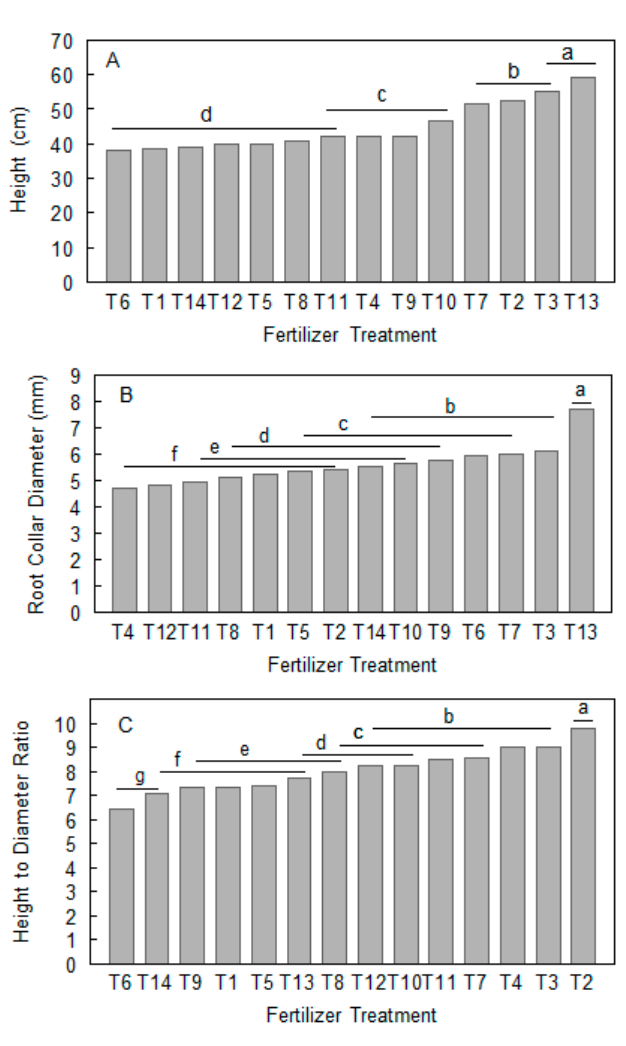
Figure 2. Phoebe bournei seedling growth attributes: ( A ) height (SE range 5.3 to 0.0); ( B ) root collar diameter (SE range 0.62 to 0.01); ( C ) height to diameter ratio (SE range 0.89 to 0.01). The means for di ff erent fertilization treatments—T1 to T14, as defined in Table 2—are listed in ascending order of treatment response. Treatment means sharing the same letter are not significantly di ff erent at ( p > 0.05) as determined by the Duncan’s multiple range test. Note: A height to diameter ratio in the range 5–7.5 provides seedlings with desirable shoot strength properties